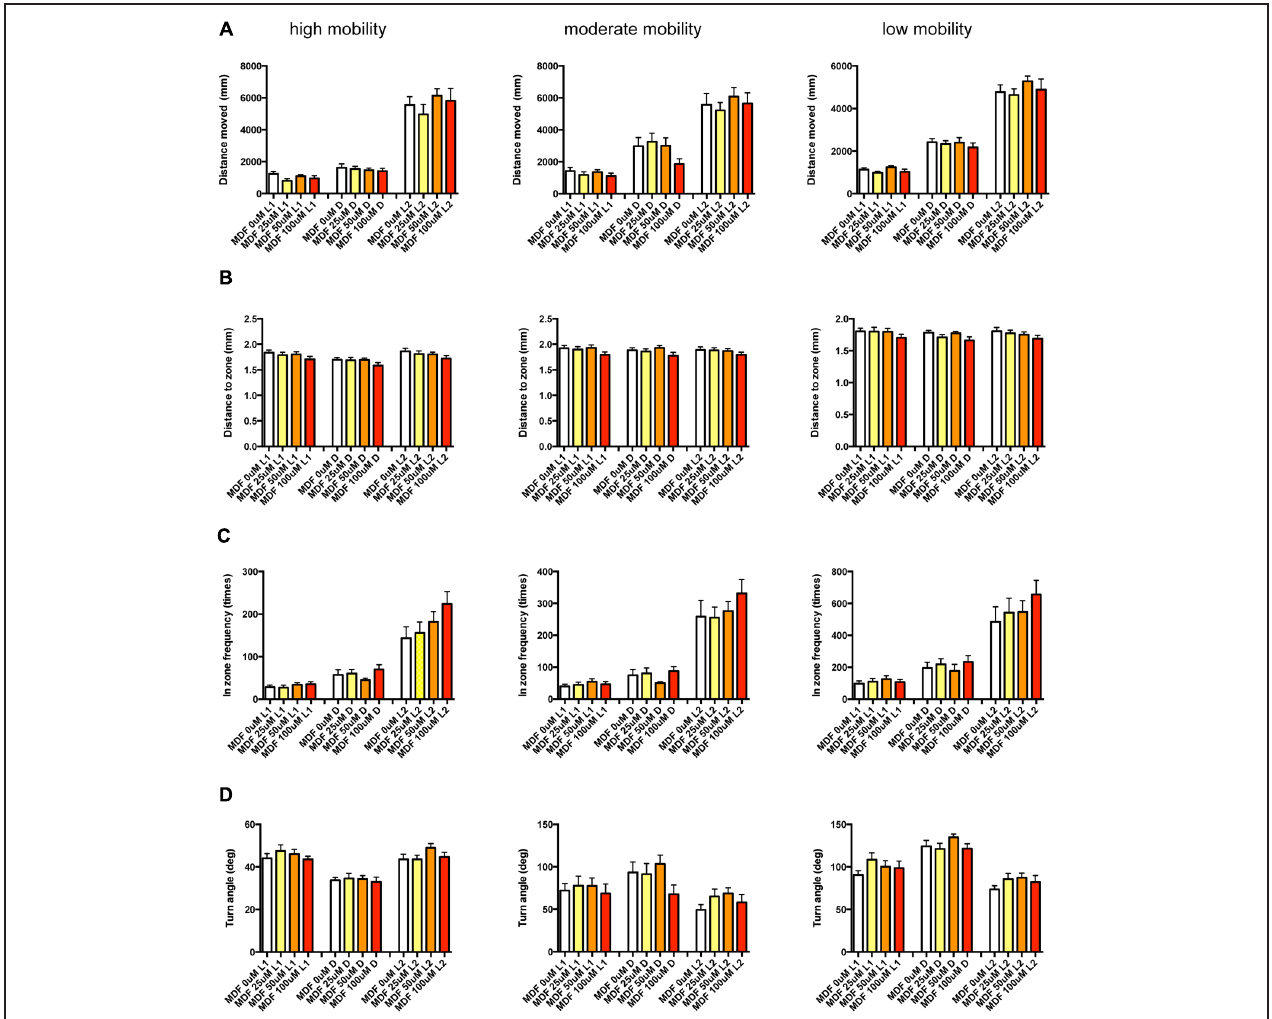
FIGURE 13 | Behavioral profiling of zebrafish treated with modafinil. The behavior of zebrafish treated with modafinil from 9 to 10 dpf was classified into three groups based on mobility. Distance moved (A) , distance to zone (B) , in zone frequency (C) , and turn angle (D) at L1, D, and L2 periods are shown for each mobility